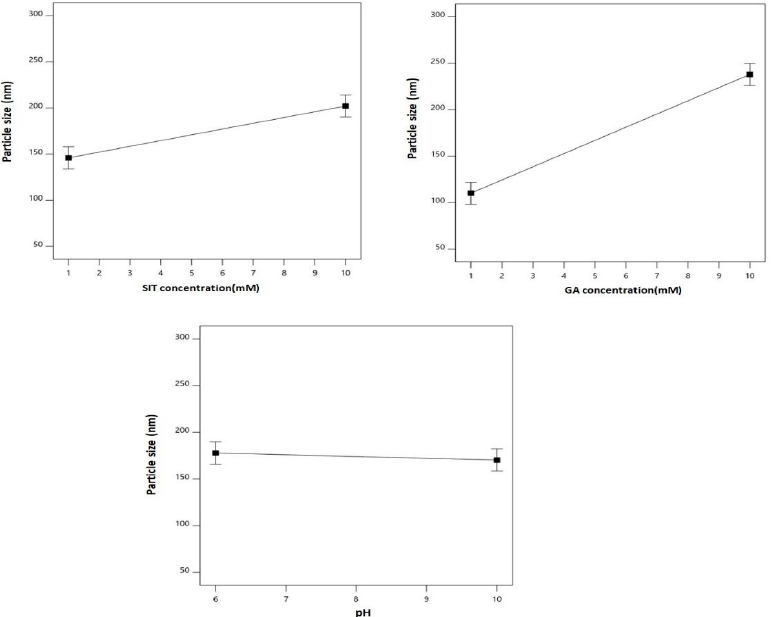
Figure 2. Main effects of the SIT concentration (X 1 ), GA concentration (X 2 ), and pH (X 3 ) on the particle size of the SIT-GA nano-conjugates.